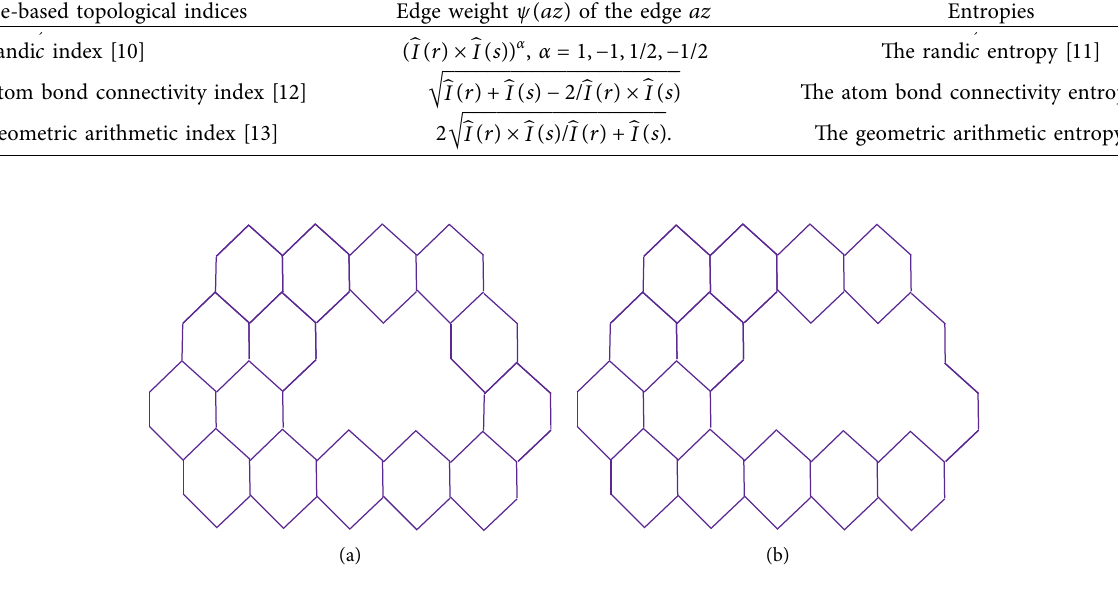
Figure 1: Coronoid and noncoronoid systems.